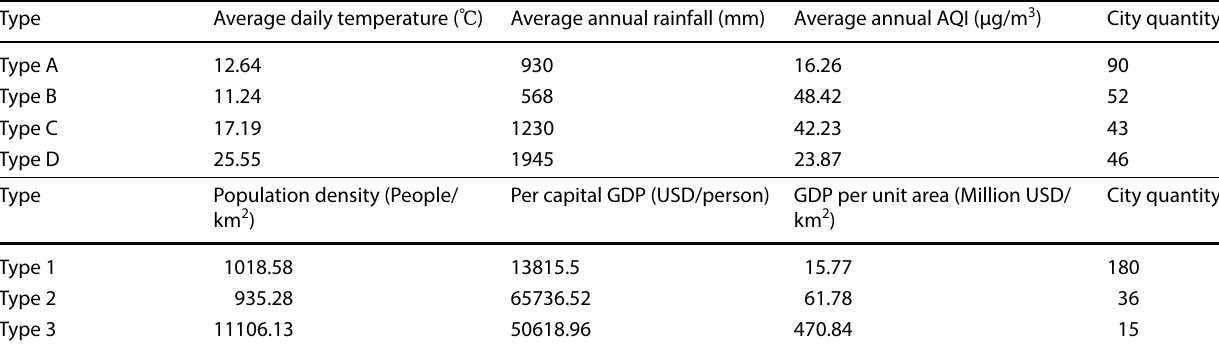
Table 5 Average value of different city